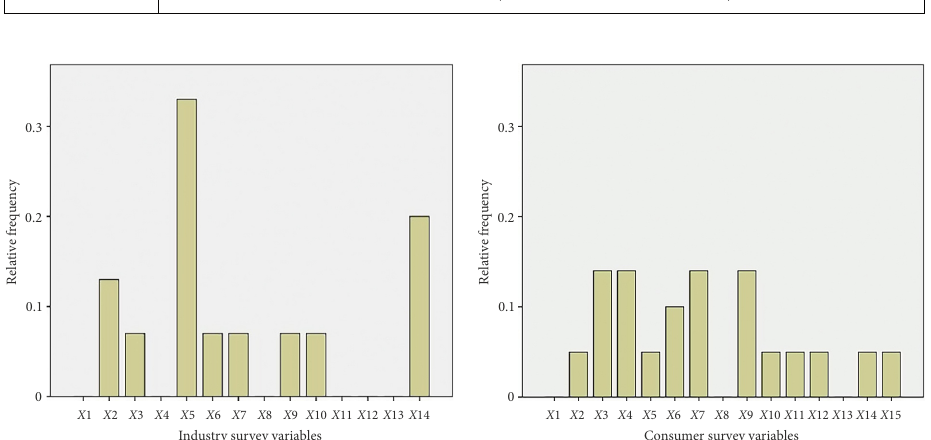
X 1 X 2 X 3 X 4 X 5 X 6 X 7 X 8 X 9 X 10 X 11 X 12 X 13 X 14 Figure 2. Bar chart – Relative frequency for survey variables